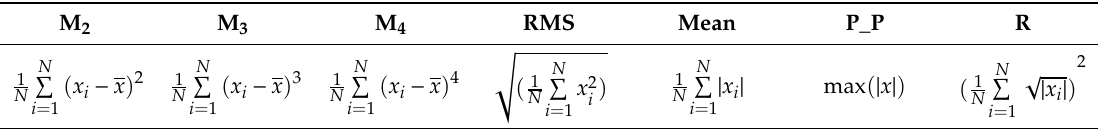
Table 4. The basic dimensional statistics.